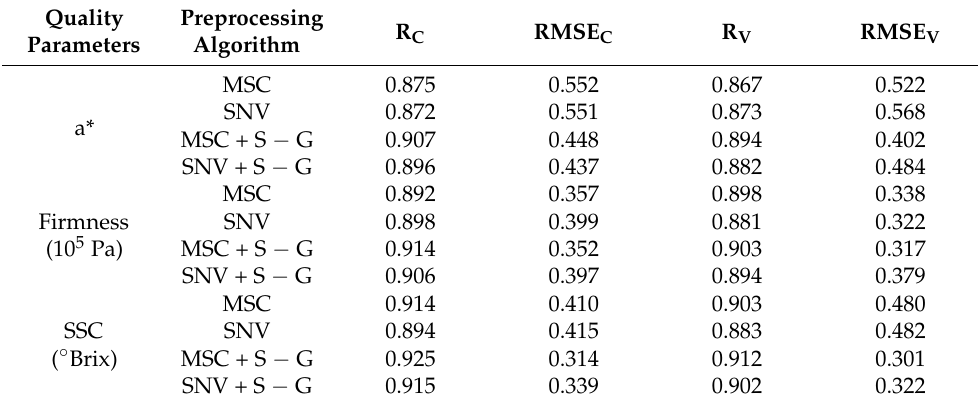
Figure 5. Selection process of principal components based on MSC-SG. ( a ) Selecting process to estimate the a* value. ( b ). Selecting process to estimate the firmness. ( c ) Selecting process to estimate the SSC. Table 3. Modeling results to estimate the quality parameters for Korla pears.